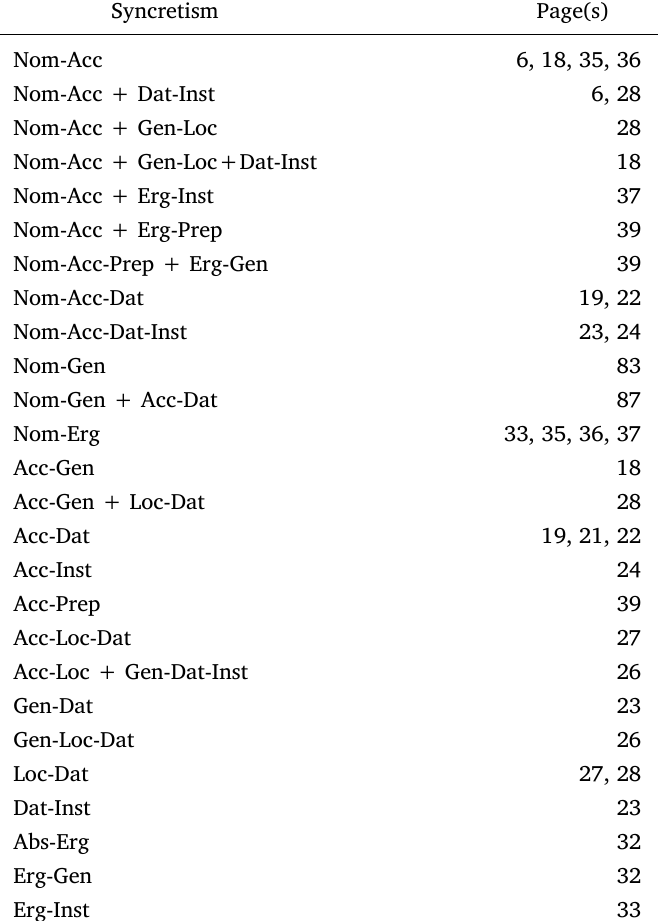
Case syncretism